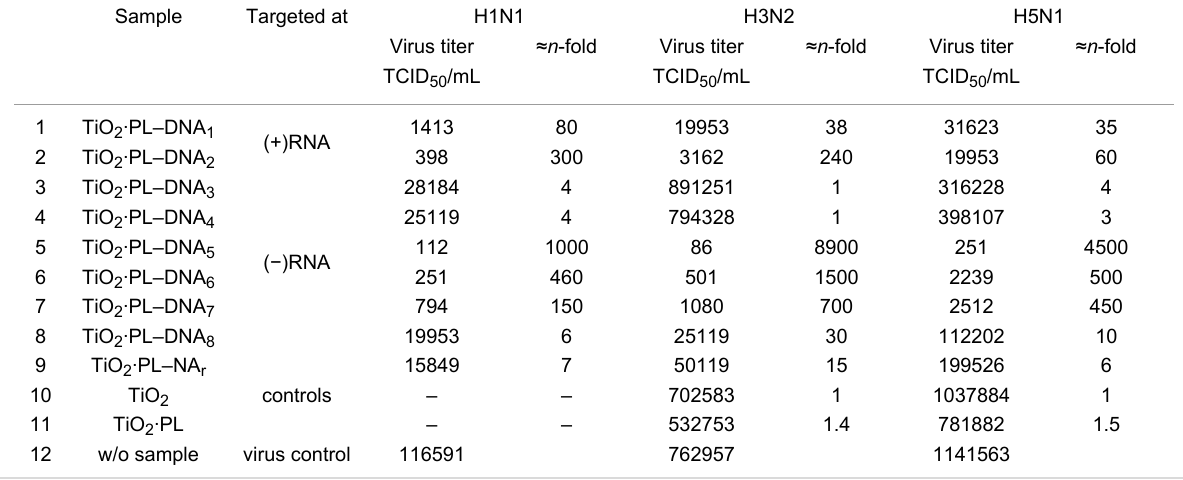
Table 2: Antiviral activity of the studied TiO 2 ·PL–DNA nanocomposites. Virus titers and inhibition of virus reproduction ( n -fold) in MDCK cells infected with different IAV subtypes after treating with nanocomposites bearing DNA fragments complementary to four conservative regions of ( − )RNA and (+)RNA of segment 5.